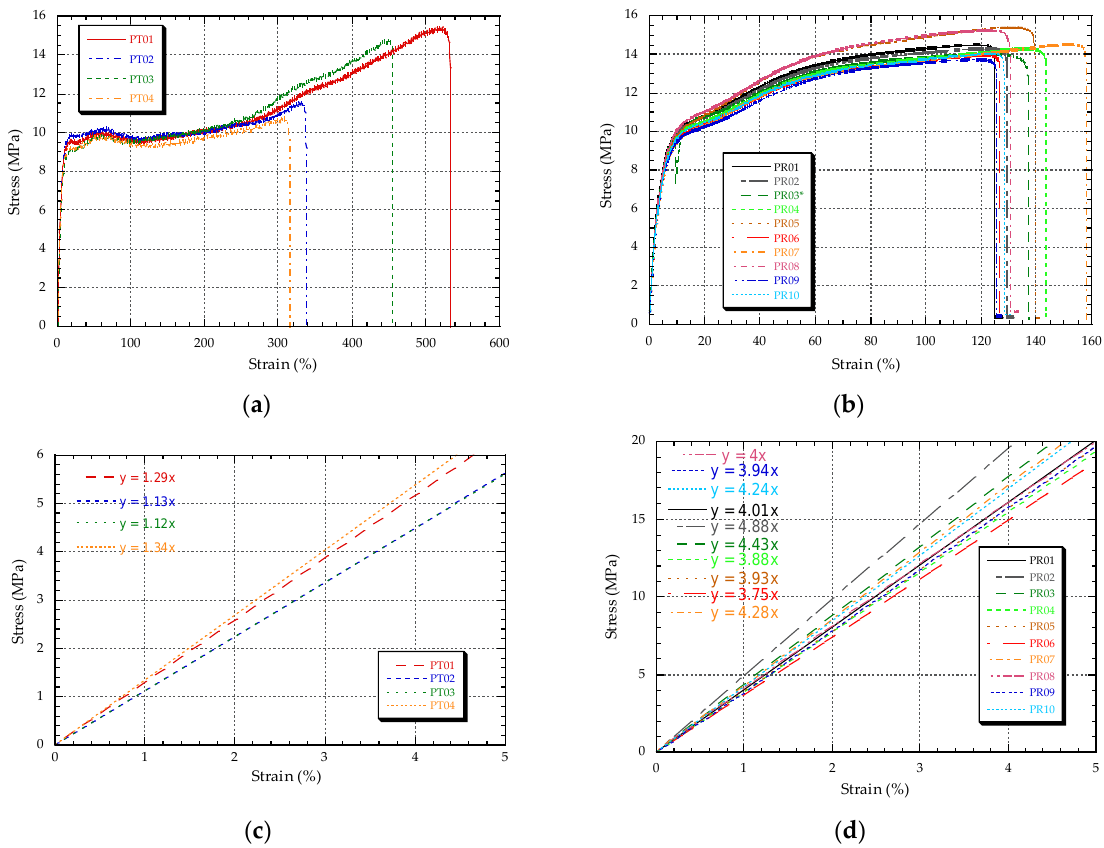
Figure 8. Stress-strain curves of polyethylene before and after being recycled. ( a ) Full stress-strain curves of material before it is valorised. ( b ) Full stress-strain curves of material after it is valorised. ( c ) Elastic section of the stress-strain curves of material before it is valorised. ( d ) Elastic section of the stress-strain curves of material after it is valorised.